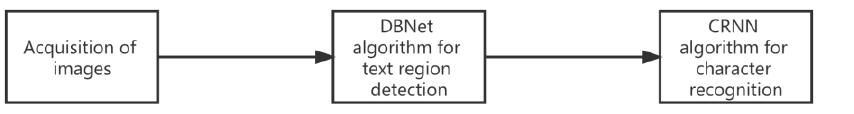
Figure 3. DBNet model network structure. Figure 4 compares the traditional text detection algorithm and the DBNet detection algorithm. The main principle of the DBNet detection algorithm is the transformation of the probability map that is generated using segmentation methods into bounding boxes and text regions, which includes binarization postprocessing. Binarization is crucial in character recognition, and the traditional binarization operation by setting a fixed thresh- old is difficult to adapt to complex and variable detection scenarios (the blue process in the figure). In this study, the binarization operation was applied to the network and opti- mized simultaneously so that the threshold value of each pixel point could be predicted adaptively, that is, using DBNet (the red flow in the figure). Its text detector involves the insertion of differentiable binarization into the segmentation network as a simple segmen- tation network. In this manner, the adaptive thresholding of the entire heat map is even- tually achieved. Figure 4. Comparison of traditional text detection algorithm and DBNet detection algorithm. The basic steps of differentiable binarization are as follows: First, the backbone and features of the input image are extracted. Subsequently, the image is passed to the feature